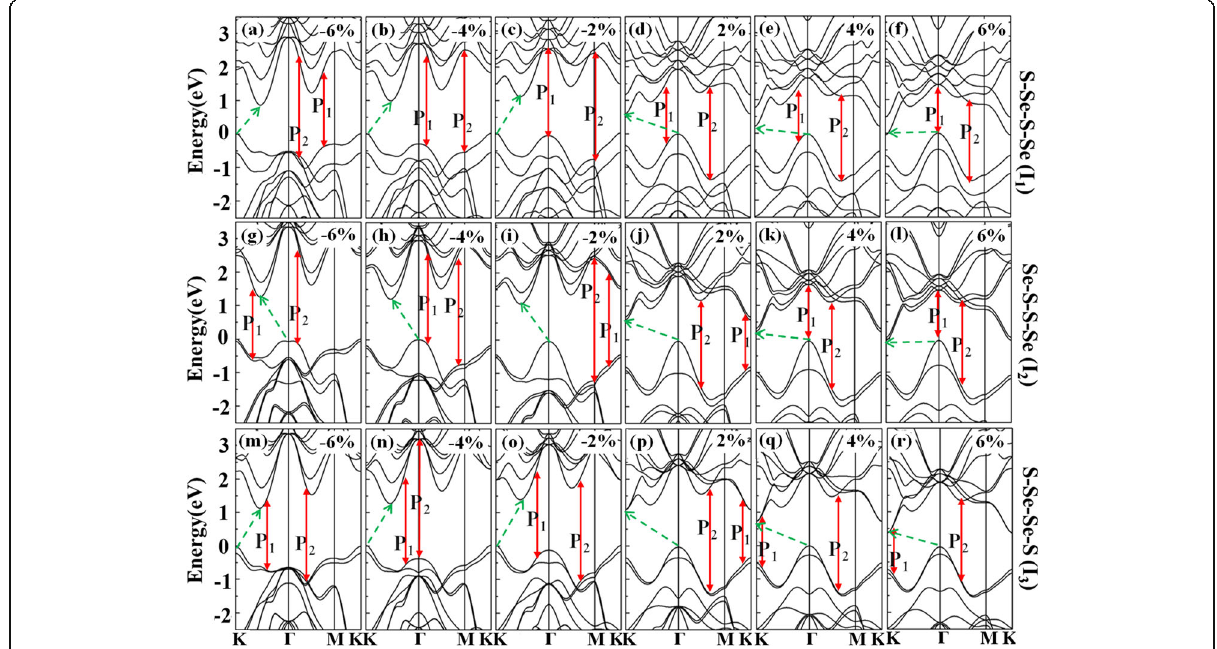
Fig. 4 a – r Band structures of I 1 , I 2 , and I 3 with different strains of − 6%, − 4%, − 2%, 2%, 4%, and 6%, respectively. The bandgaps are denoted with the dashed green arrows, while red solid arrows depict the principal interband transitions of P 1 and P 2 , respectively